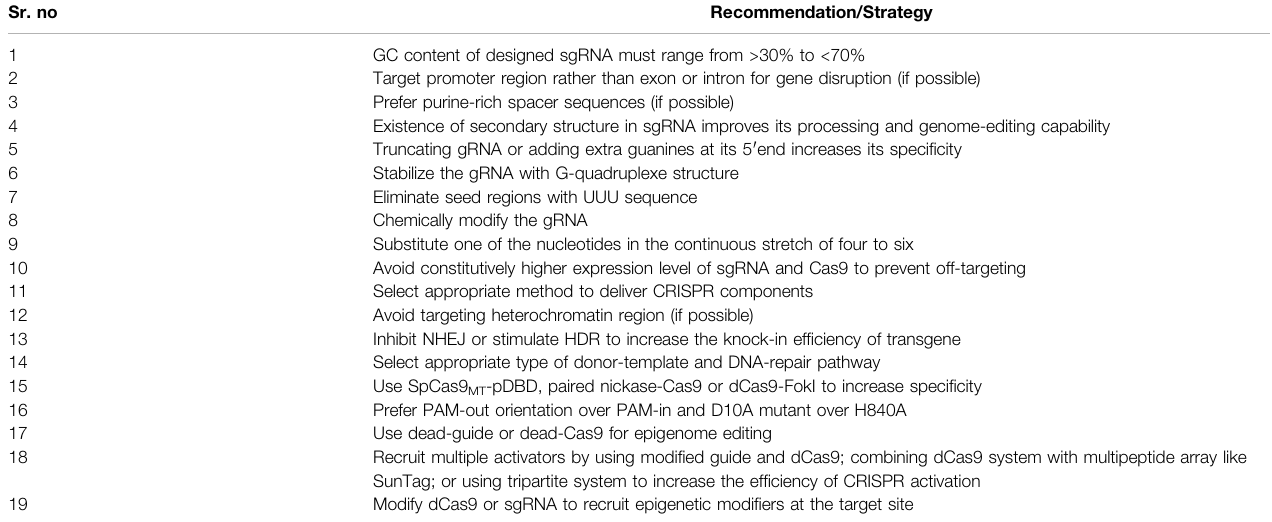
TABLE 1 | Summary to enhance the ef fi ciency of CRISPR-mediated genome and epigenome editing. Sr.